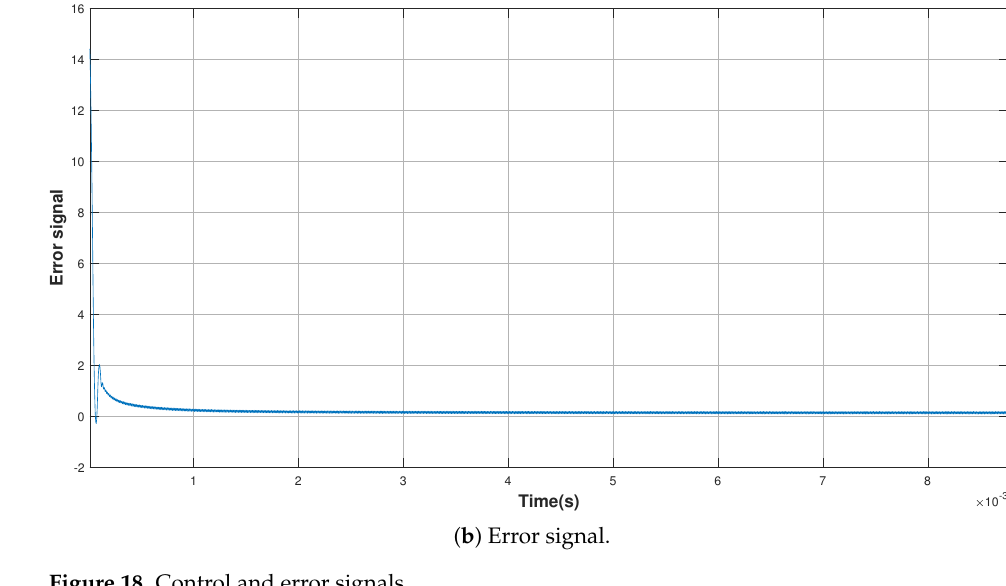
Figure 18. Control and error